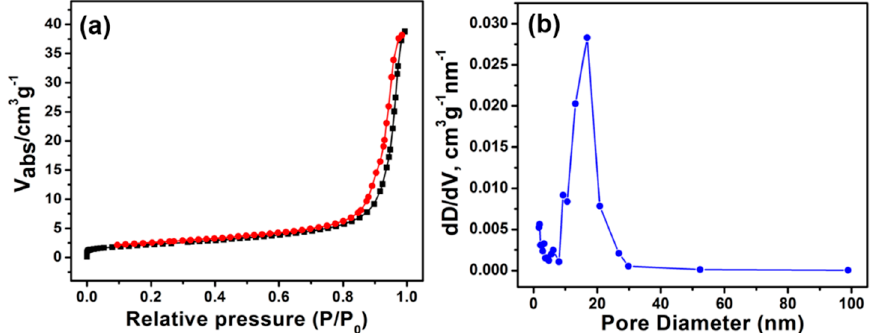
Figure 6. The ( a ) N 2 adsorption-desorption isotherm and ( b ) pore size distribution plot of the synthesized mesoporous Mn 2 O 3 materials.